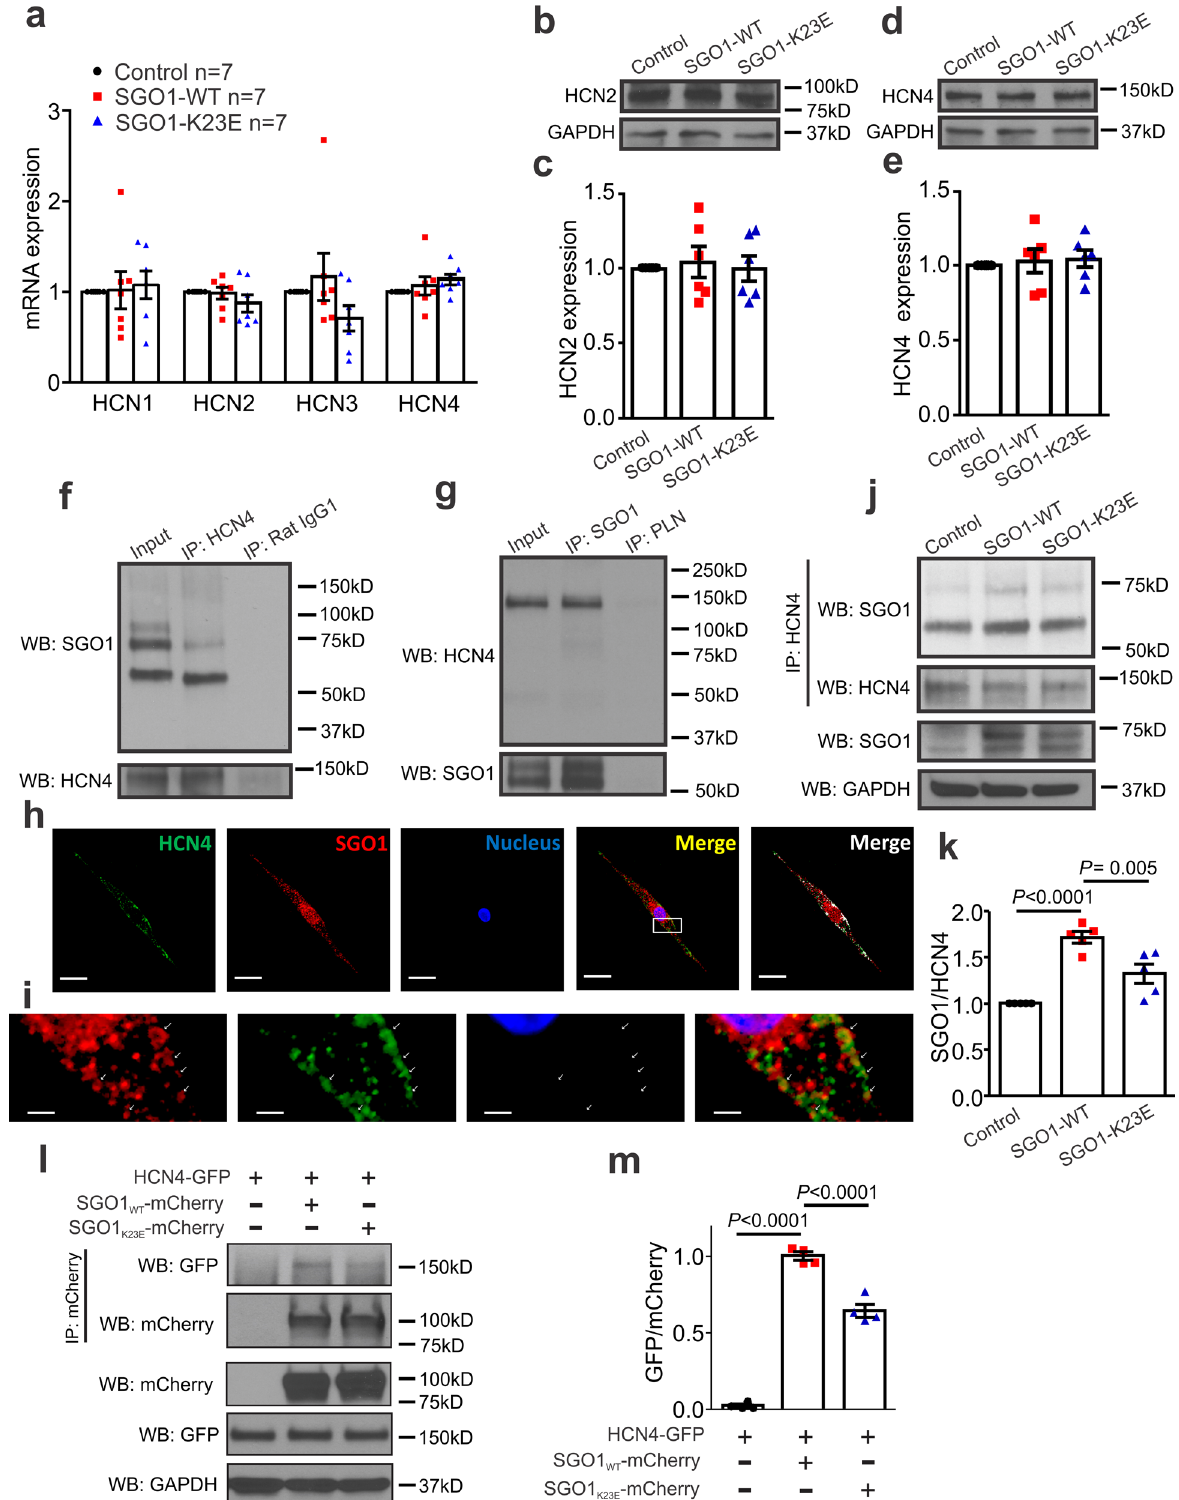
under similar conditions. Co-IP showed that transduction with human SGO1-WT increased the amount of SGO1 interacting with rat HCN4 (Fig. 4j, k). SGO1 enhances NRVM automaticity by interacting with rat HCN4. To further evaluate the interaction between SGO1 and HCN4, we labeled human HCN4 with green fl uorescent protein (GFP) and labeled human SGO1 with mCherry, then assessed the interaction between the two fusion